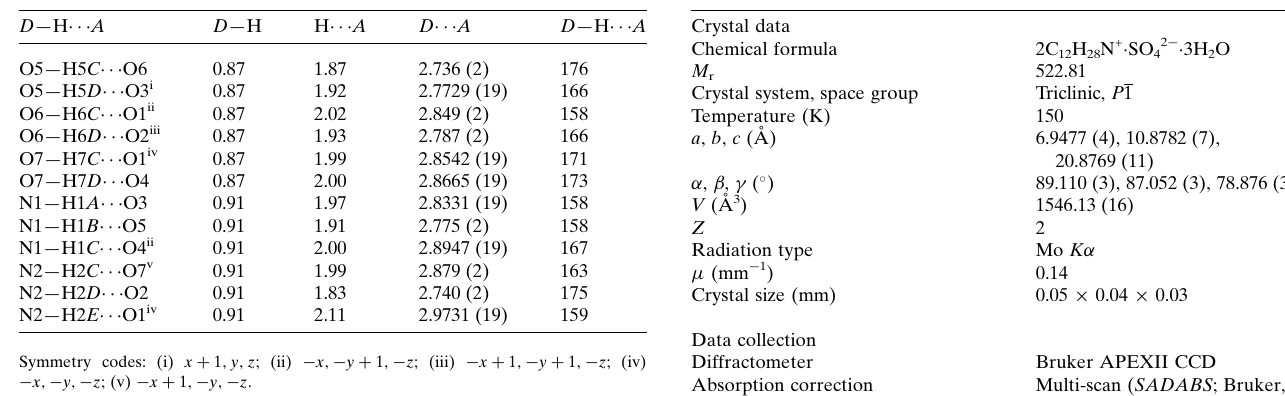
Table 2 Experimental details.